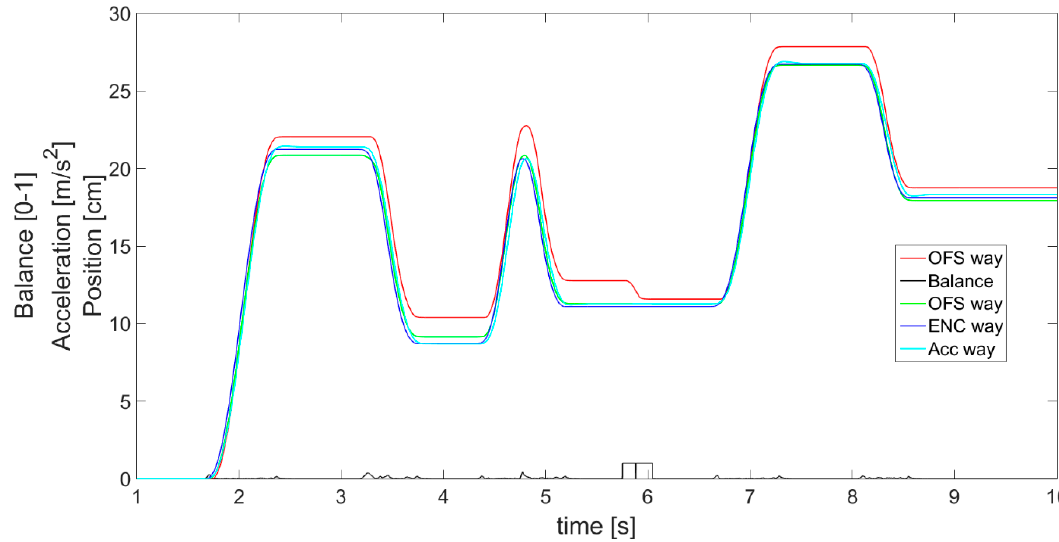
Figure 18. Complementary filter effects presented with displacement plots.